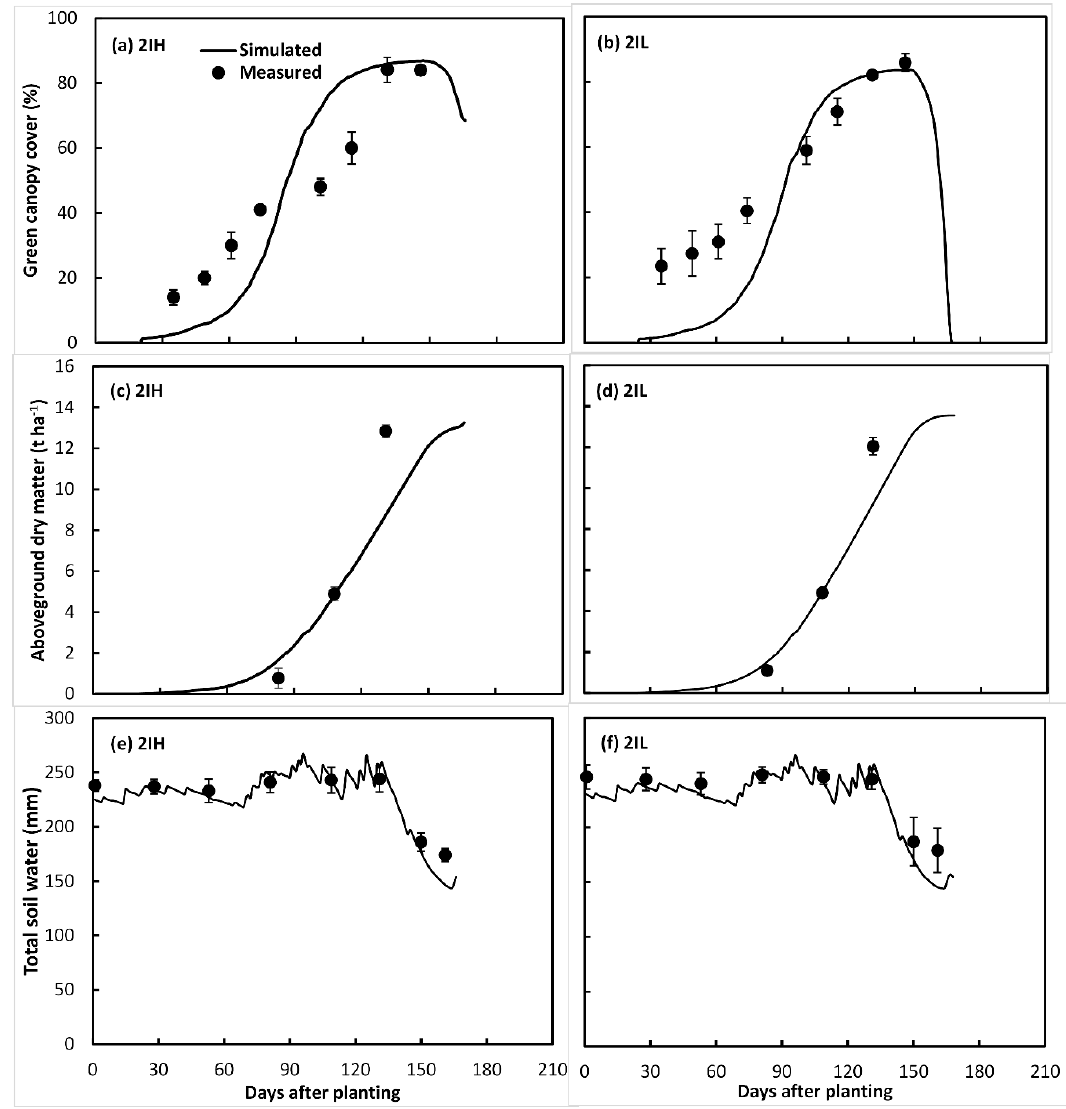
Figure 13. Measured and simulated green canopy cover (CC), above-ground dry matter (AGDM), and total soil water (TSW) for high and low sowing rates. ( a ) Measured and simulated CC for 2IH; ( b ) measured and simulated CC for 2IL; ( c ) measured and simulated AGDM for 2IH; ( d ) measured and simulated AGDM for 2IL; ( e ) measured and simulated TSW for 2IH; ( f ) measured and simulated TSW for 2IL.